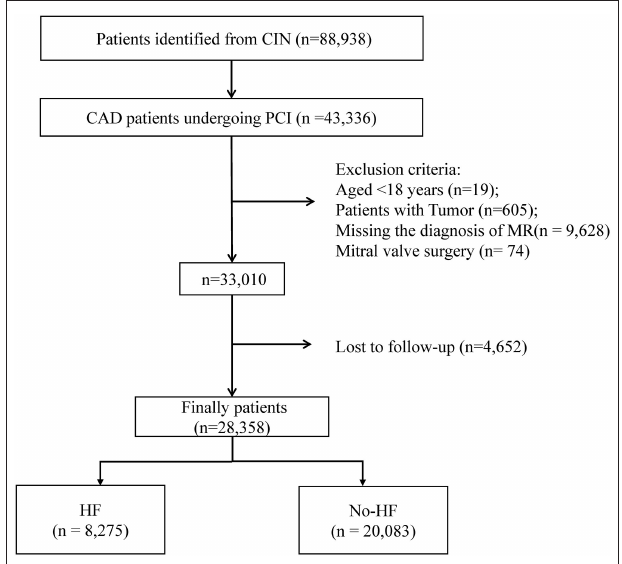
FIGURE 1 | Flow of participants through the